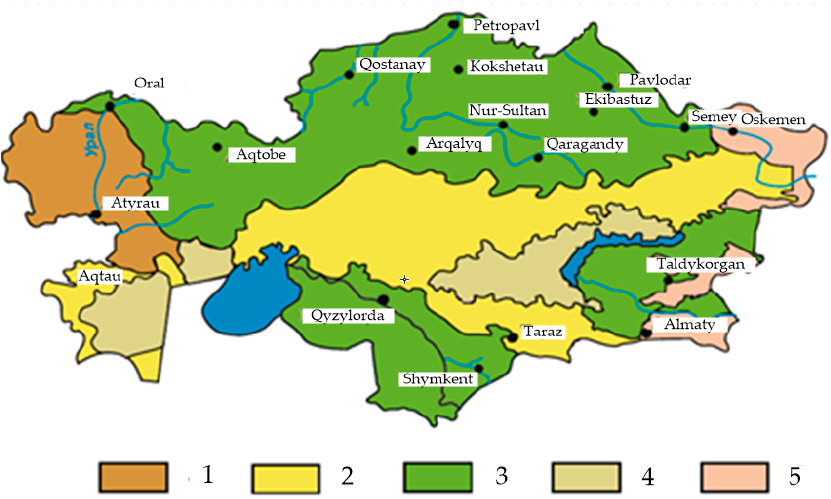
Figure 1. Map of saline soils of Kazakhstan according to NTP RK 07-01.1-2011 [2]: ( 1 ) chloride and sulfate-chloride; ( 2 ) sulfate; ( 3 ) sulfate and chloride-sulfate; ( 4 ) gypsum salinization; ( 5 ) insignificant salinity soils.